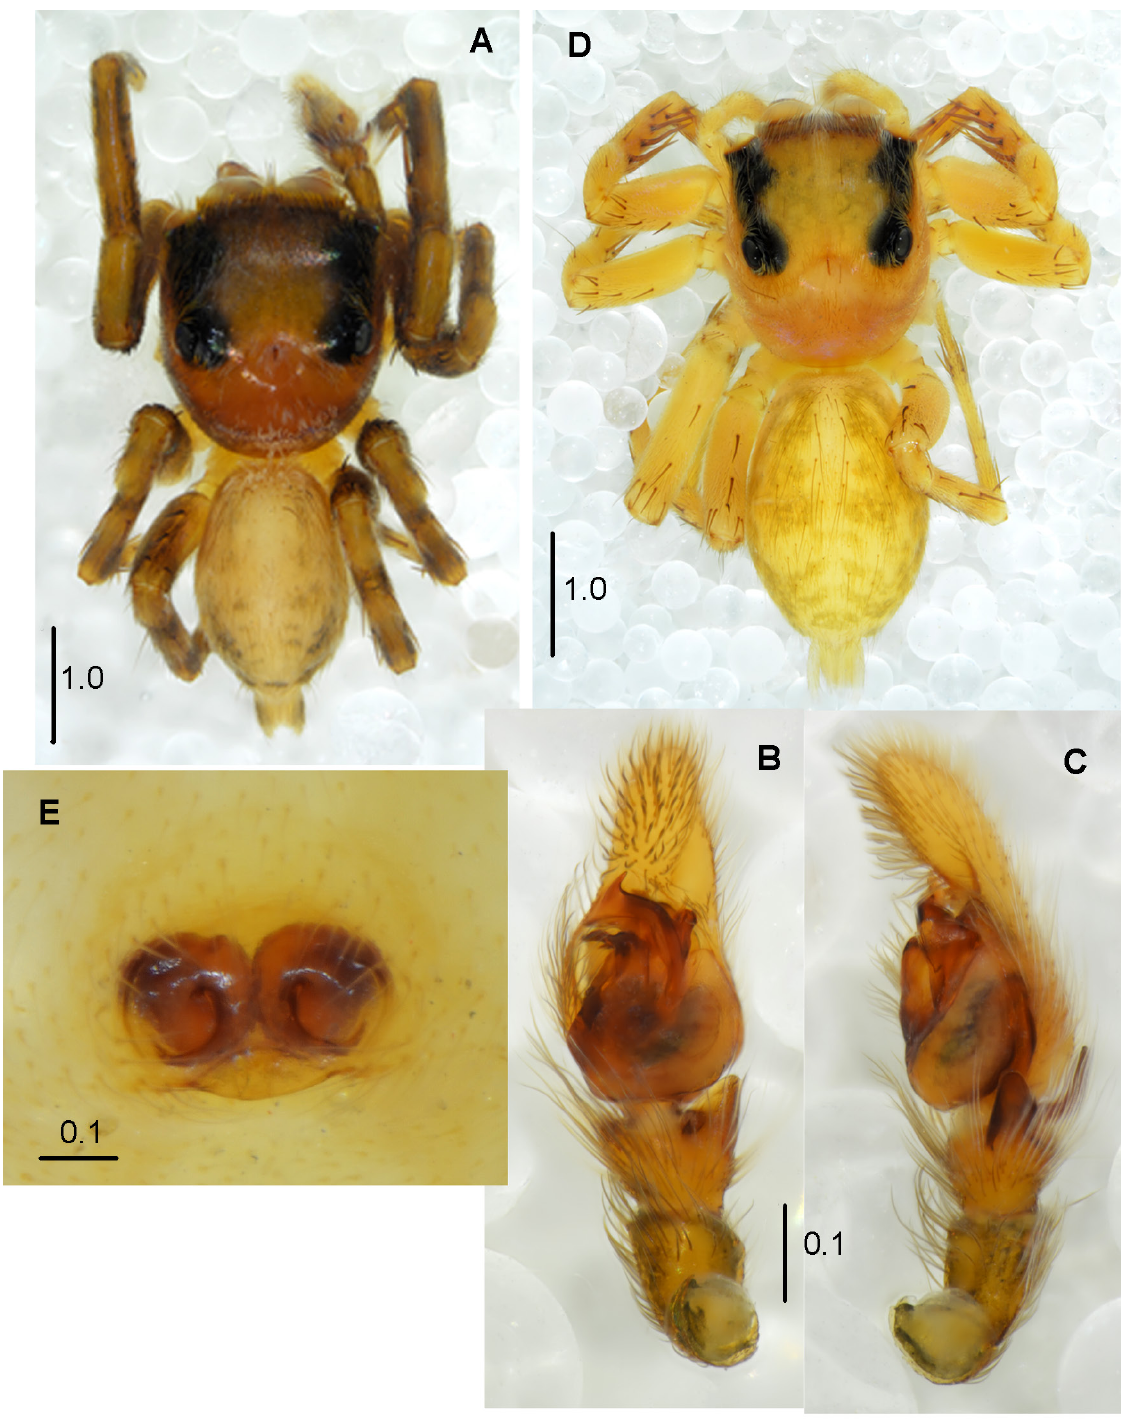
Fig. 50. Pochytoides mirabilis sp. nov. A–C . Holotype, ♂ (MNHN). D–E . Paratype, ♀ (MNHN). A . Habitus of male, dorsal view. B . Palpal organ, ventral view. C . Palpal organ, lateral view. D . Habitus of female, dorsal view. E .